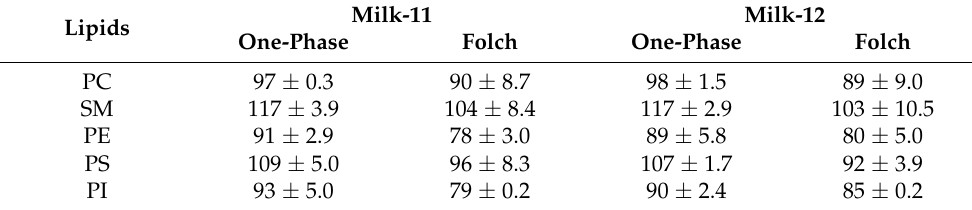
Table 4. Matrix effect (%) in relation to lipid extraction methods.